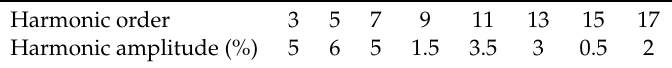
Table 1. Harmonic frequency contents from EN 50160.